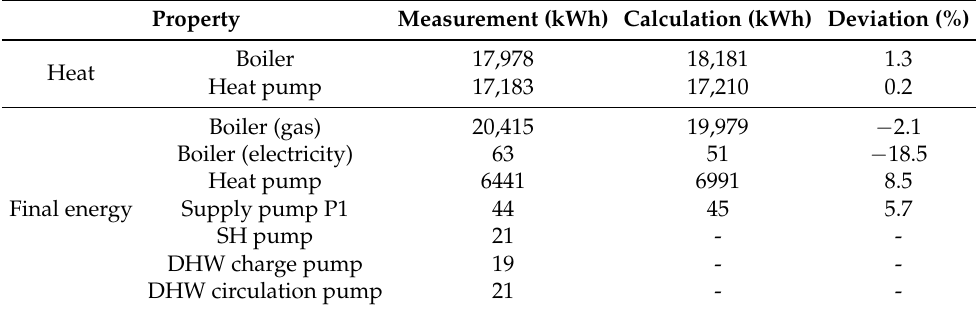
Table 4. Measured and internally calculated provided and used energy with respective